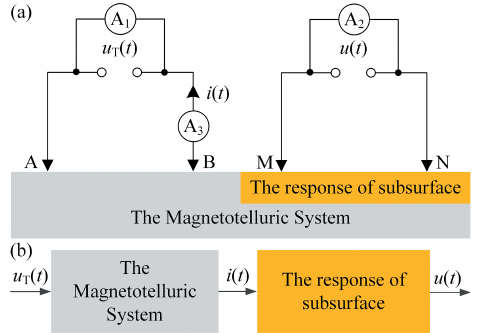
Figure 1. (a) The observation model of the four-electrode measure- ment. (b) Its equivalent